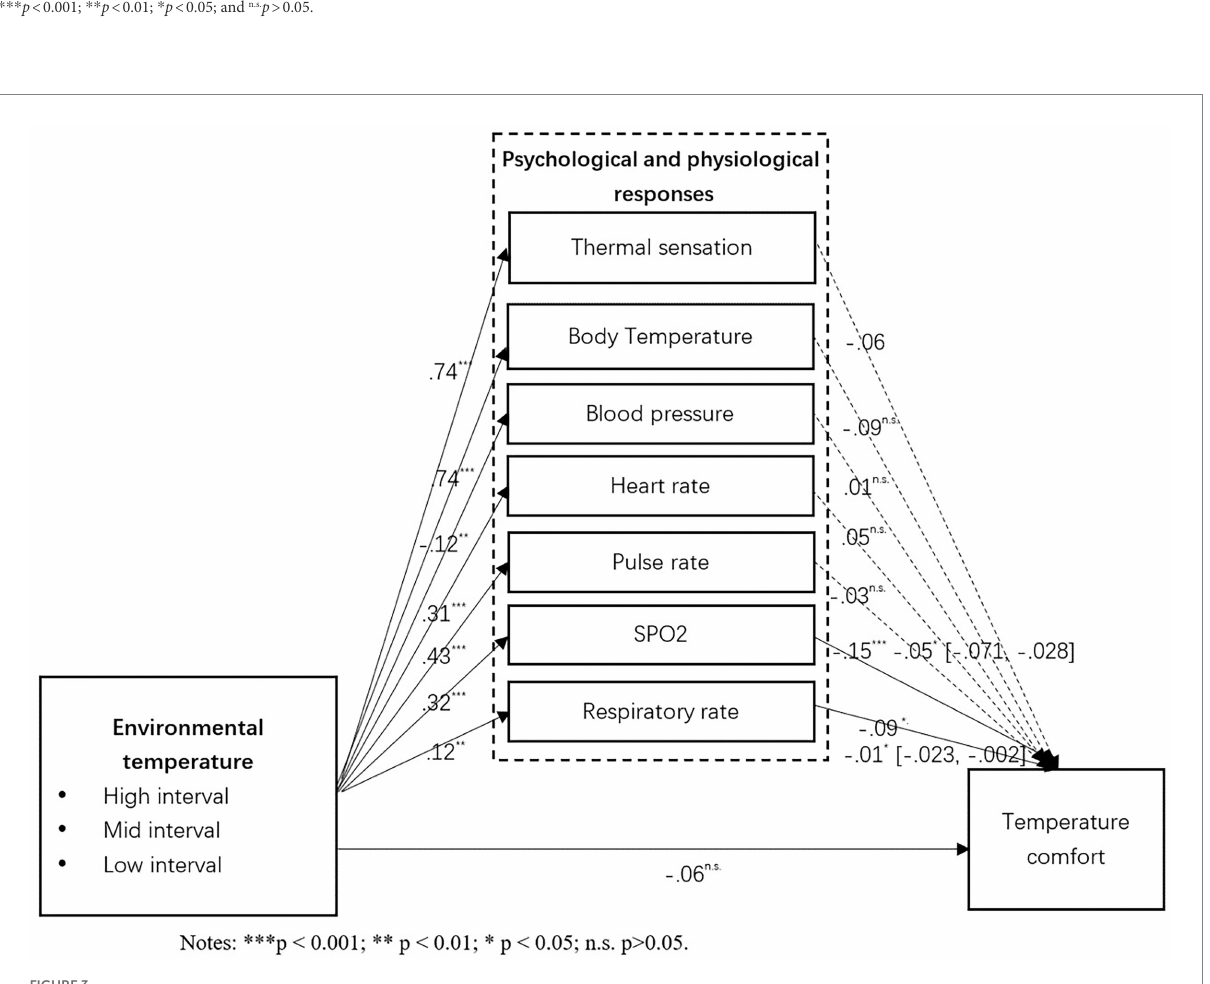
confirmed among visual condition and temperature comfort. However, psychological response thermal sensation did not show a significant mediating effect between all three independent variables and temperature comfort. These findings have partially supported H10, H11, and H12.